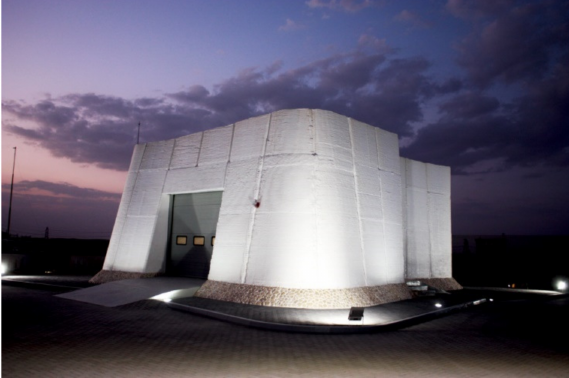
Figure 18. CyBe completed Dubai laboratory [50]. Reprinted with permission from Ref. [50]. 2022,